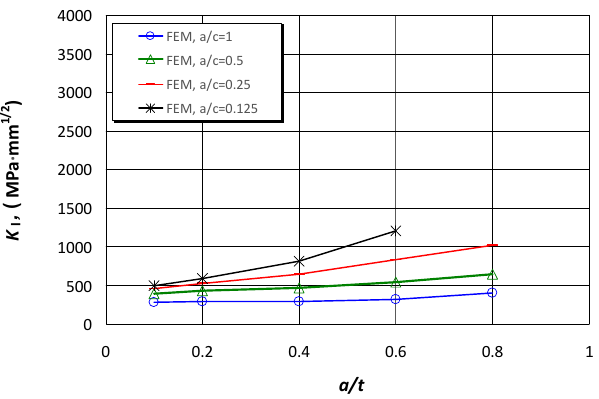
Figure 12. SIF solutions for crack parallel to weld line ( α = 0°).